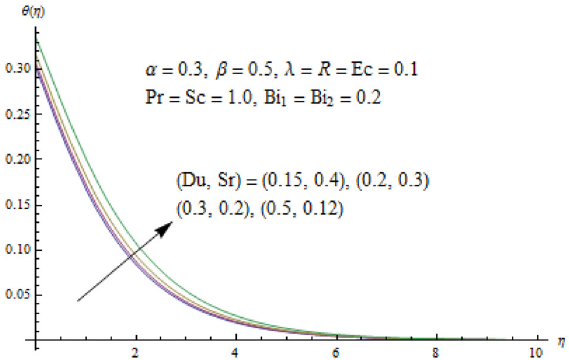
Fig. 19 Impact of Du and Sr on θ(η)